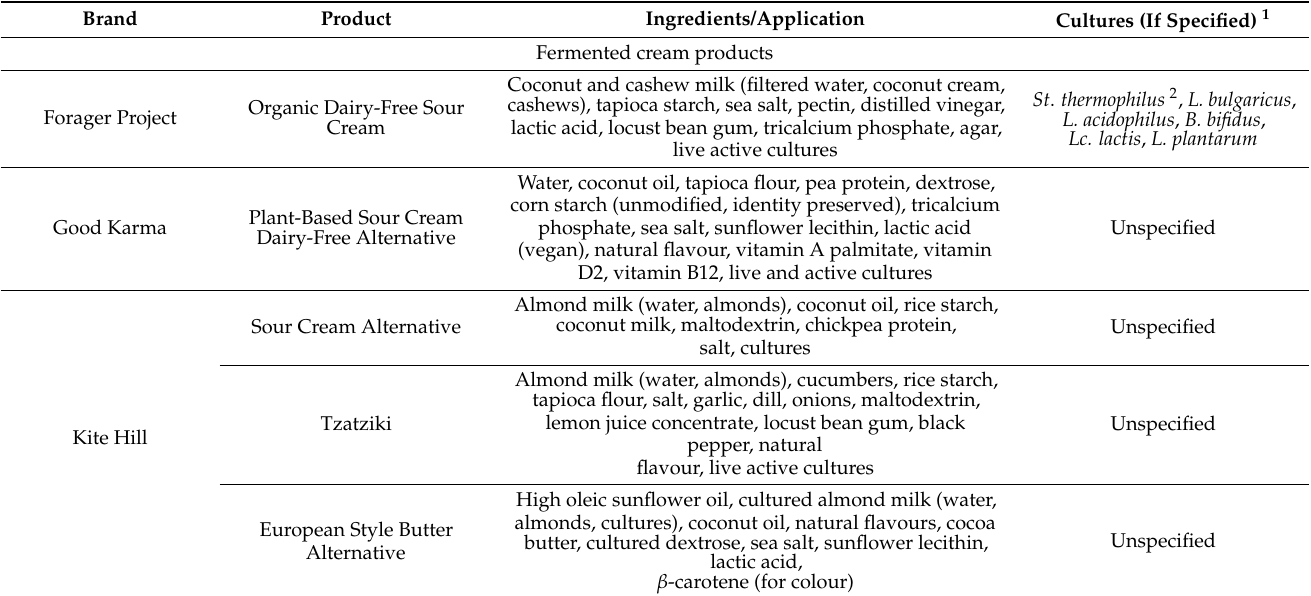
Table 3. Some examples of fermented plant-based dairy analogues on the market and commercial starter